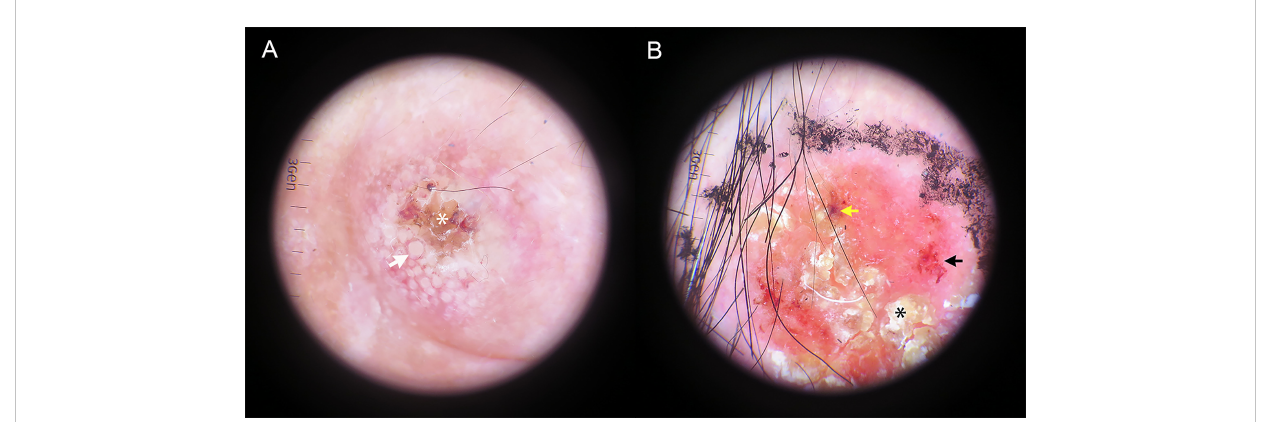
FIGURE 2 Dermatoscopic image of hrSCC without biopsy. (A) Targetoid-appearing hair follicle openings (white arrow) can be seen around the amorphous central keratotic area (white asterisk). (B) A red predominant color, yellow-white scale (black asterisk), dotted/glomerular vessels (black arrow) and blood spots (yellow arrow) are seen.